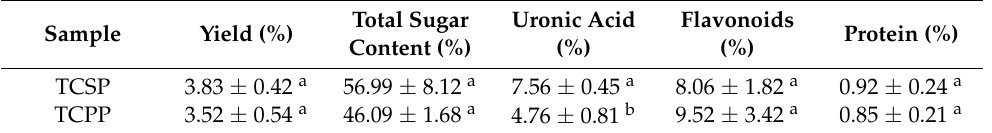
Table 1. Yield and main components of polysaccharides from stems and petals of Trollius chinensis Bunge (mean ± standard